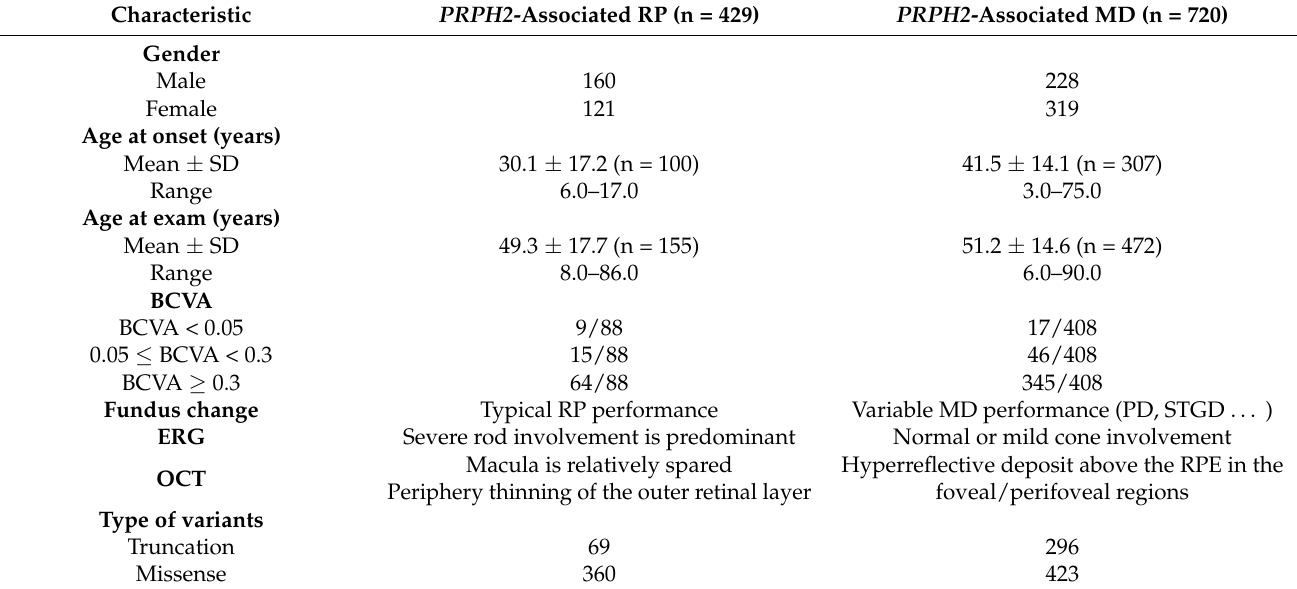
Table 2. Clinical characteristics of patients with PRPH2 -associated